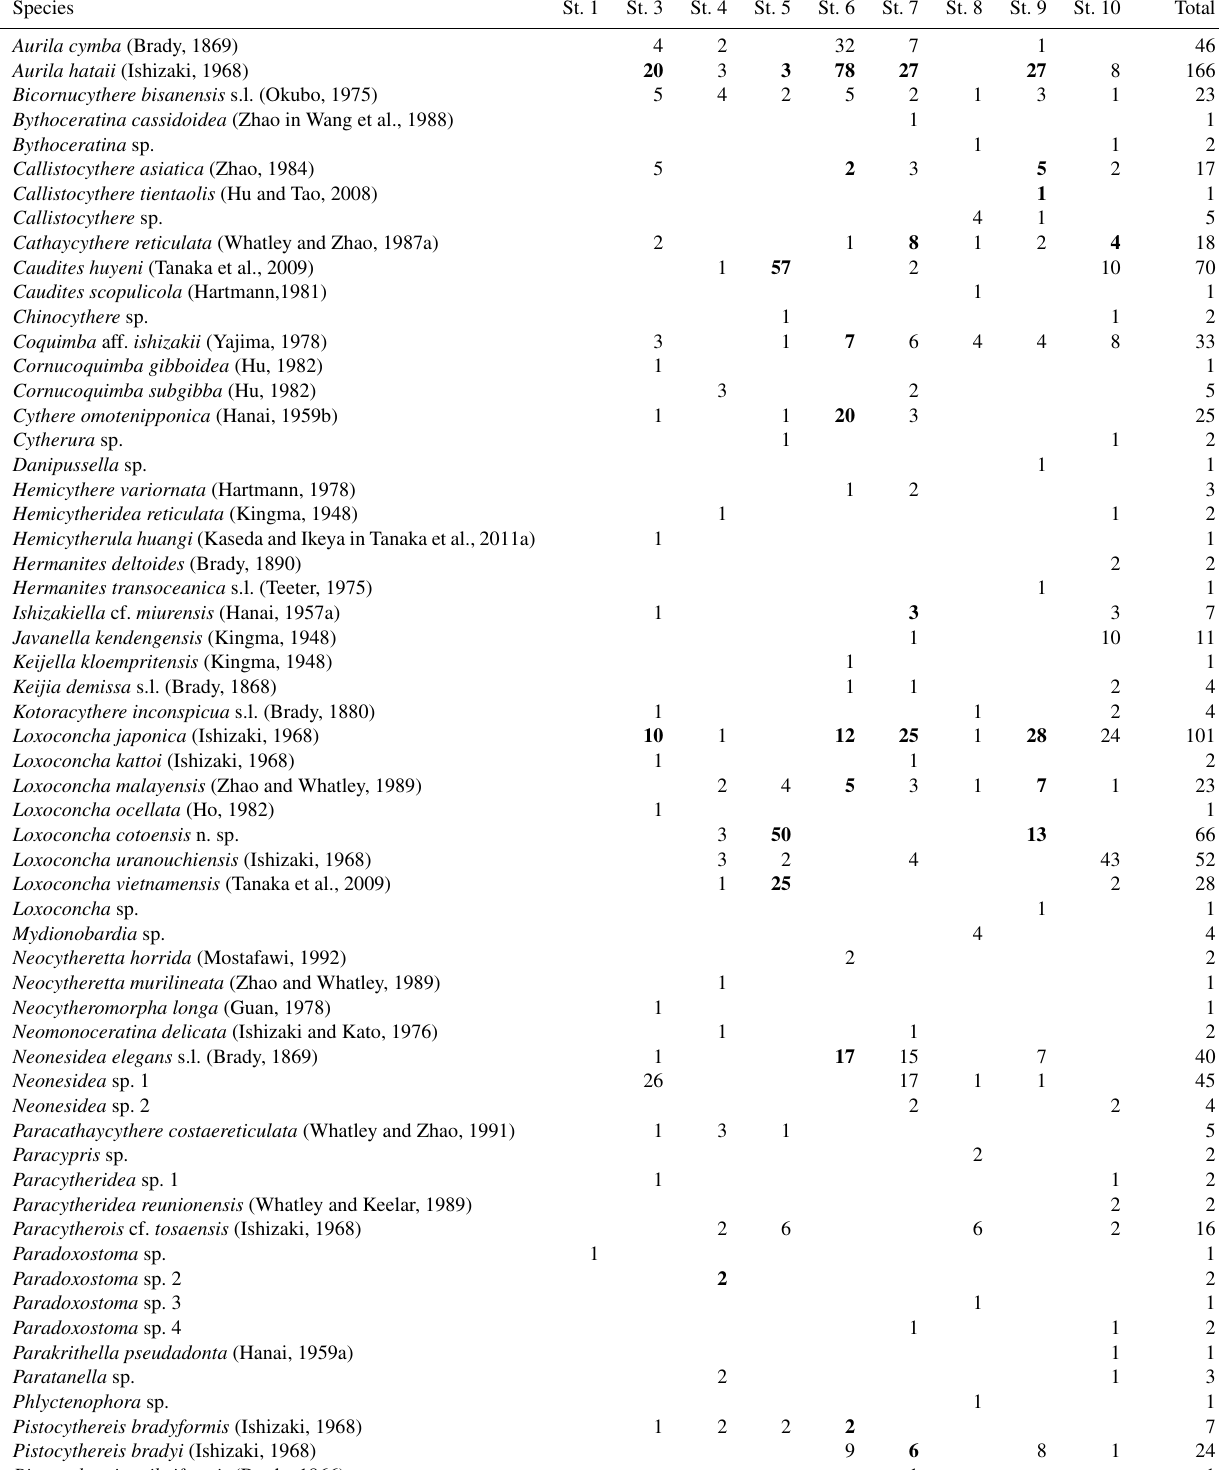
Table 2. List of ostracod species from the Co To Islands. Bold numbers indicate species that included living specimens.